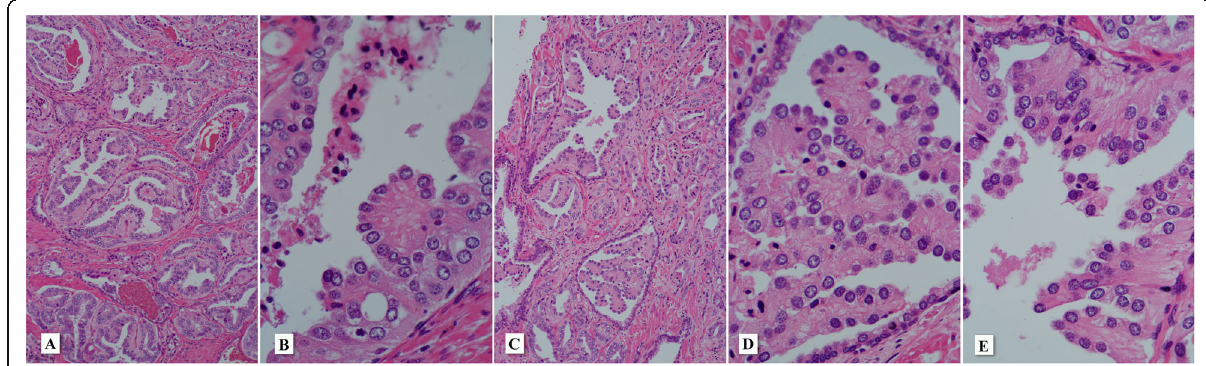
Fig. 2 Small micropapillary projections in invasive prostatic adenocarcinoma with pseudohyperplastic morphology and inverse polarity ( A-D ). This proliferation can be seen within preexistent ducts with bland double epithelial layer suggesting colonization of benign glands ( C-E ). Hematoxylin and eosin stain: A (100x), B (400x), C (100x), D (400x) and E